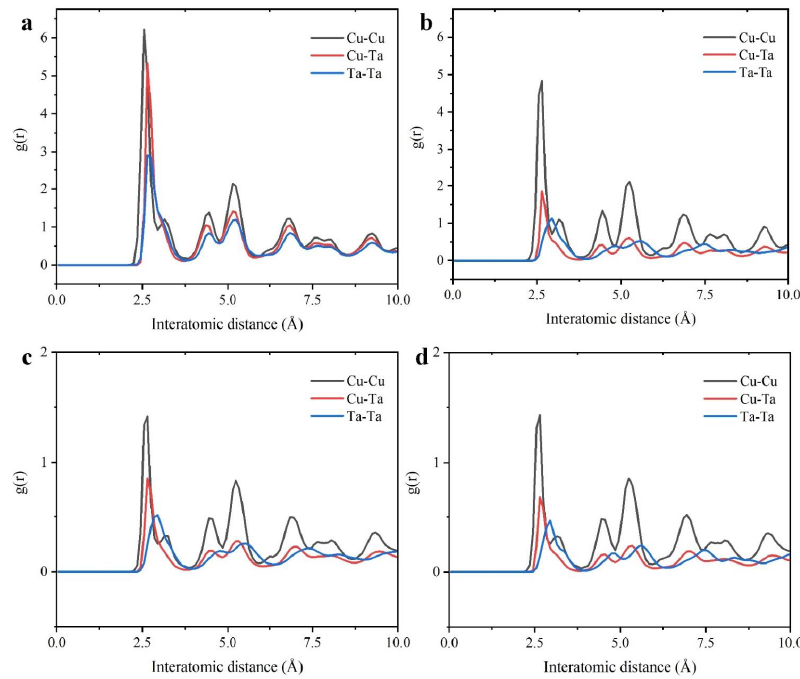
Figure 7. The RDF profile of deposit Cu-Ta model at different time. ( a ) 200 Ps; ( b ) 800 Ps; ( c ) 1200 Ps; ( d ) 1800 Ps. ( d ) 1800